Question: Is the quantity shown trending increasing or decreasing?
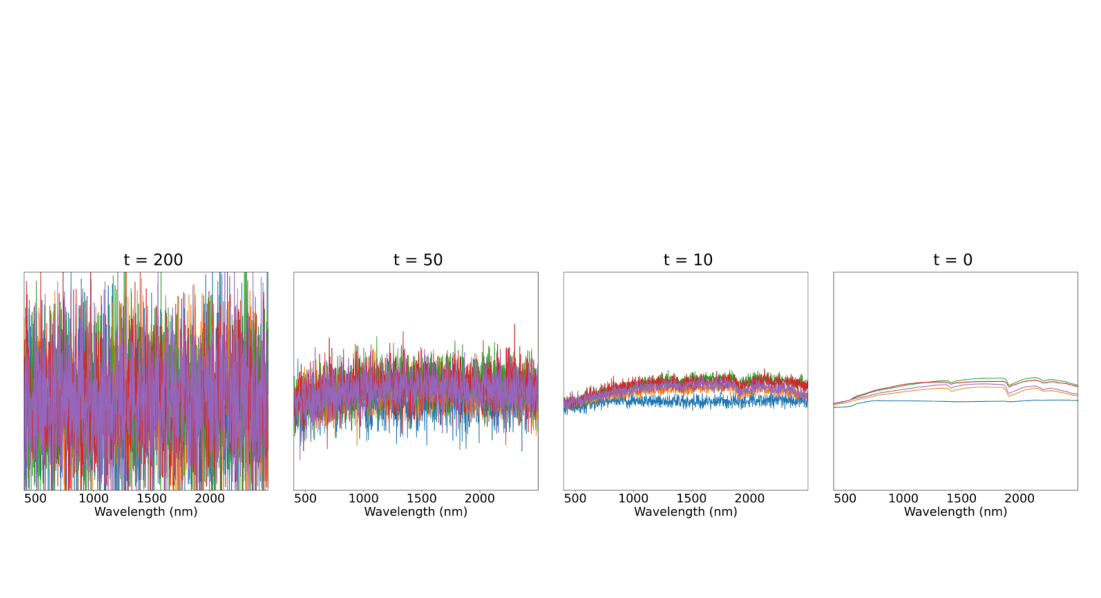
Answer: decreasing